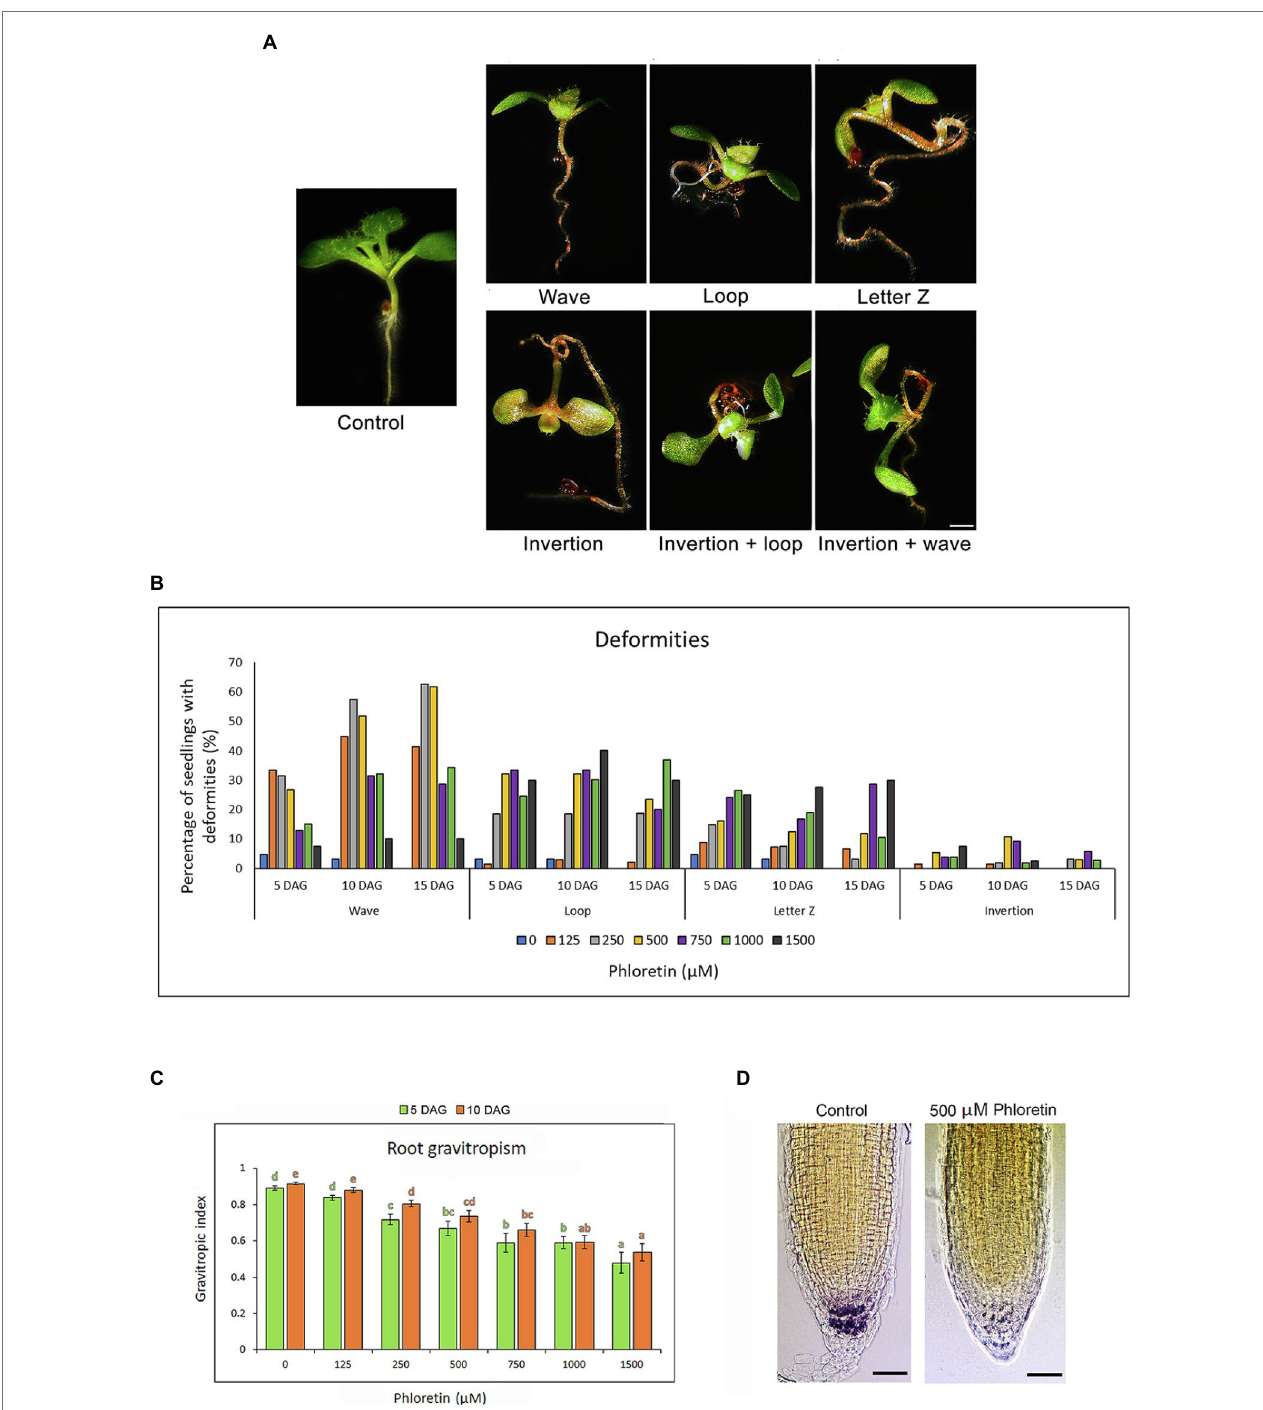
FIGURE 4 | Phloretin alters the gravitropic response and induces developmental deformities in Arabidopsis. Seeds were grown vertically on medium supplemented with phloretin in increasing concentrations (0, 125, 250, 500, 750, 1,000 and 1,500 μ M). (A) Developmental deformities in 10 d after germination (DAG)-old seedlings: wave, loop, letter Z, inversion, inversion and loop, and inversion and wave; Bar, 1 mm. (B) Percentage of plants with deformities at different phloretin concentrations at 5, 10 and 15 DAG. (C) Vertical gravitropic index (VGI) in 5 and 10 DAG-old seedlings vertically grown at different phloretin concentration. Values represents means ±SE of 30 explants per each treatment repeated three times ( n = 90). Values followed by different letters of the same color are significantly different at p < 0.05 per Fisher’s least significant difference (LSD) test. (D) Lugol’s solution starch staining of 10 DAG-old control and 500 μ M phloretin treated seedlings grown vertically. The starch in columella is colored dark purple. The representative images are shown out of three independent experiments with 10 seedlings for each experiment. Bar, 50 μ